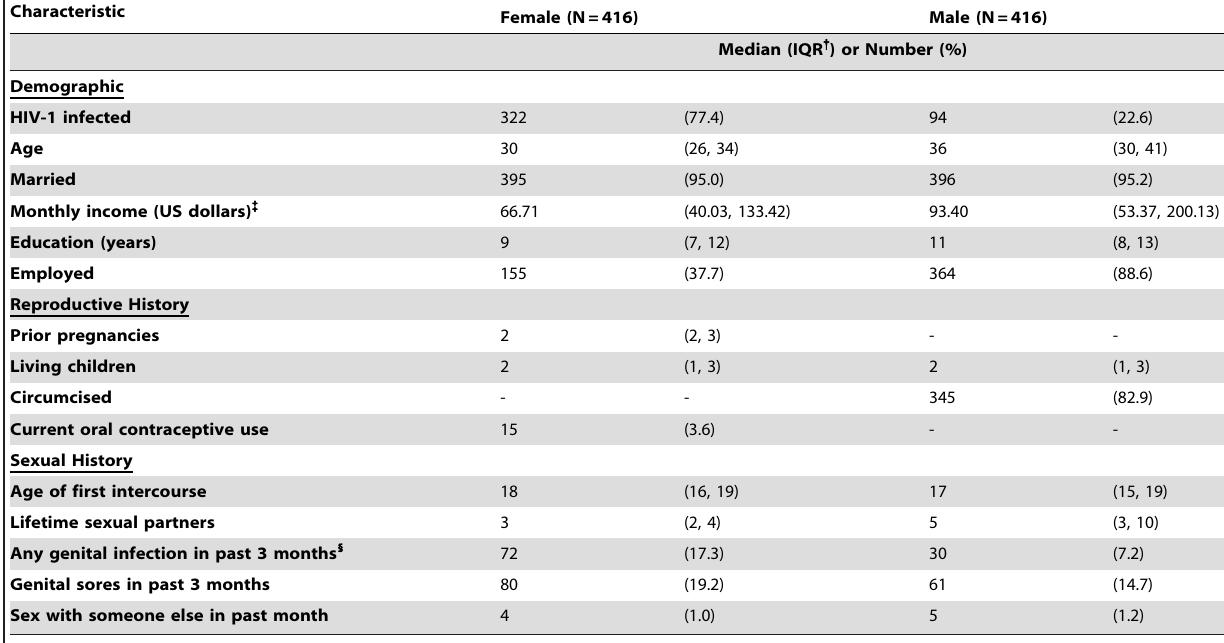
Table 1. Characteristics of study participants.*